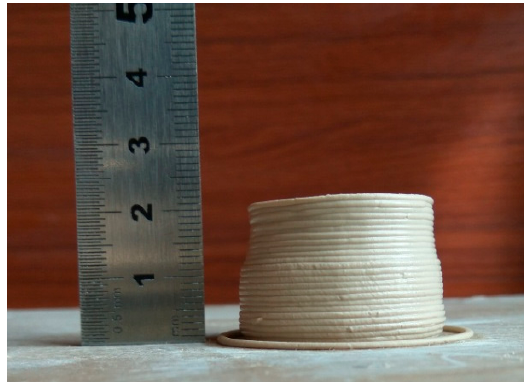
Figure 5. A solid cylinder part with the diameter 30mm and height 20mm.